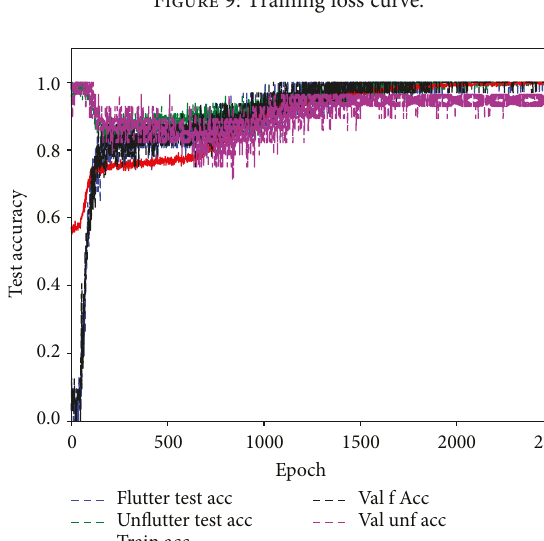
Figure 9: Training loss curve.